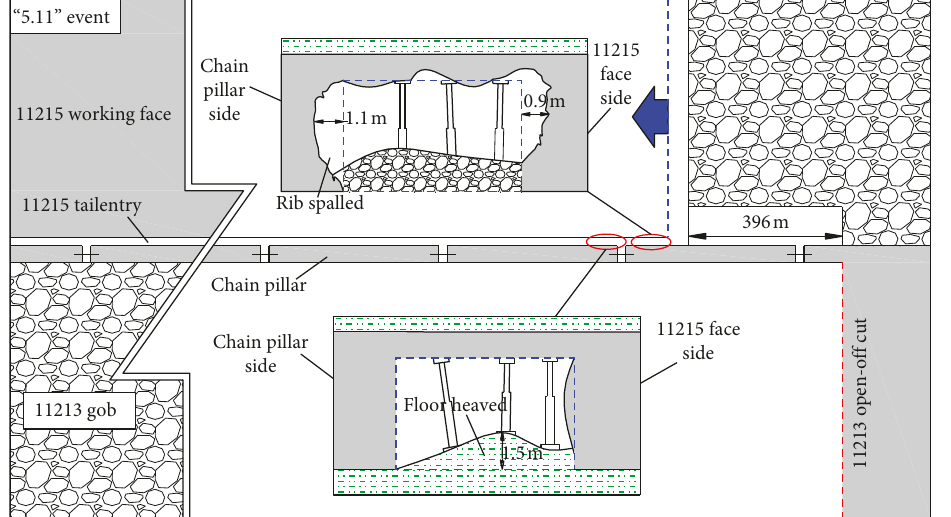
Figure 5: Sketch of the “5.11”